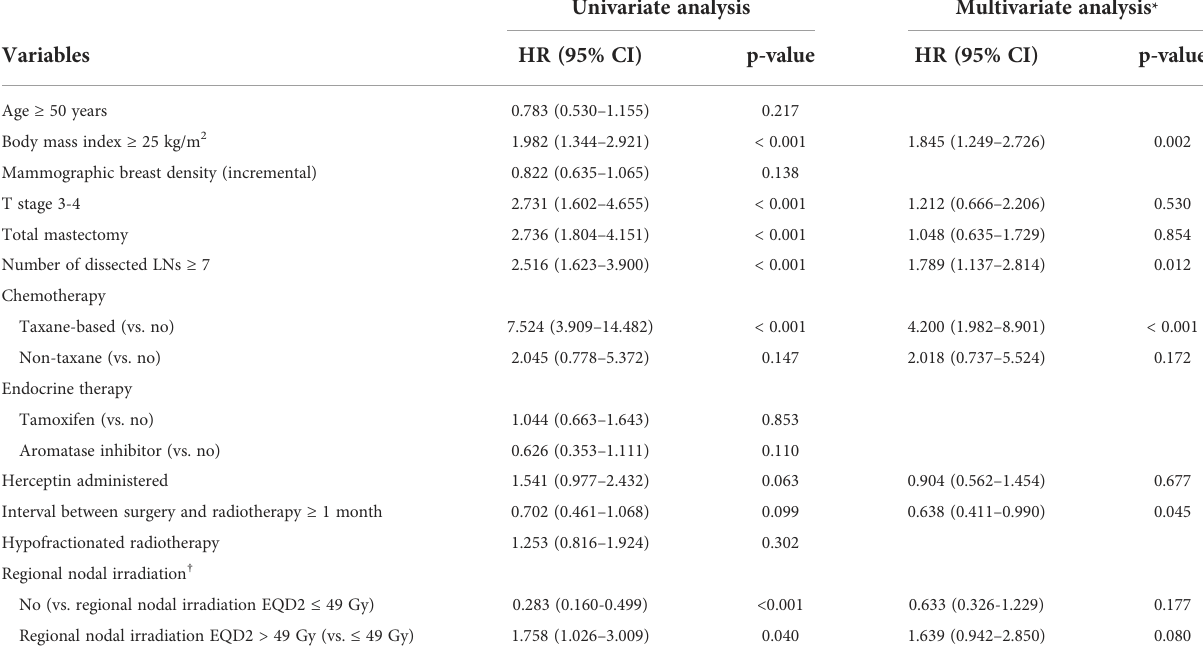
TABLE 2 Univariate and multivariate analyses of factors associated with lymphedema development (n = 580). Univariate analysis Multivariate analysis